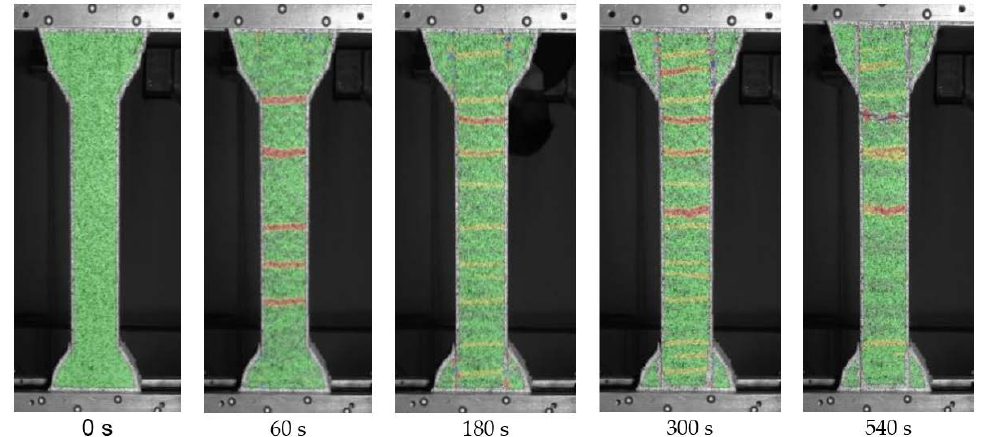
Figure 18. Crack propagation in SHCC samples during uniaxial tension test.